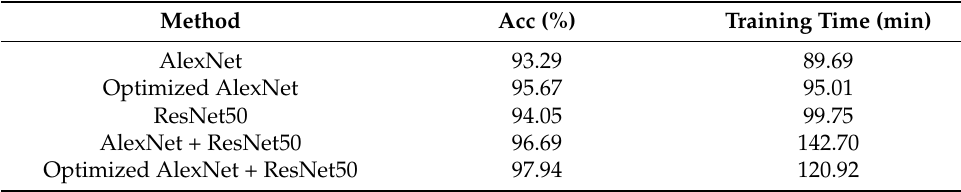
Table 3. Accuracy comparison of different algorithm models.